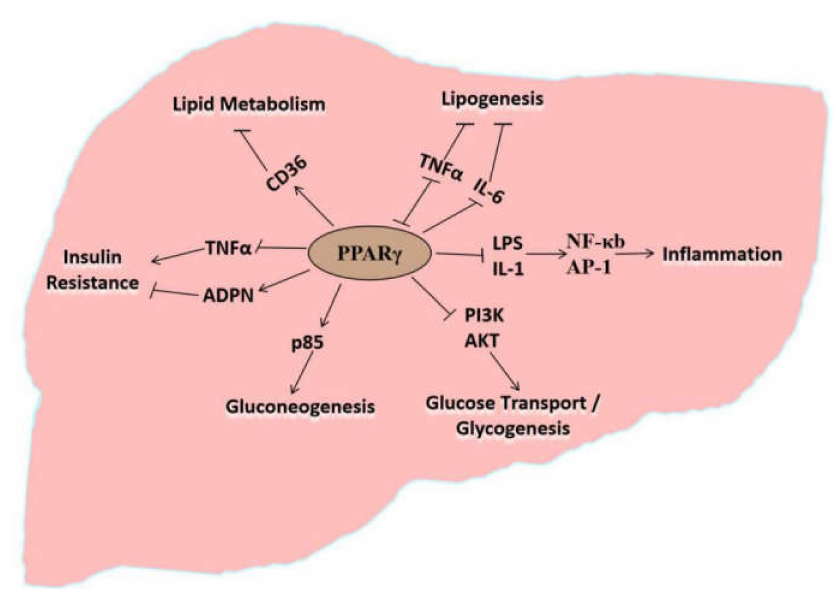
Figure 1. Peroxisome proliferator-activated receptor γ (PPAR γ ) participates in regulation of liver associated biological processes through di ff erent signaling factors and / or cytokines. Arrows indicate positive regulation and blunt arrows indicate negative